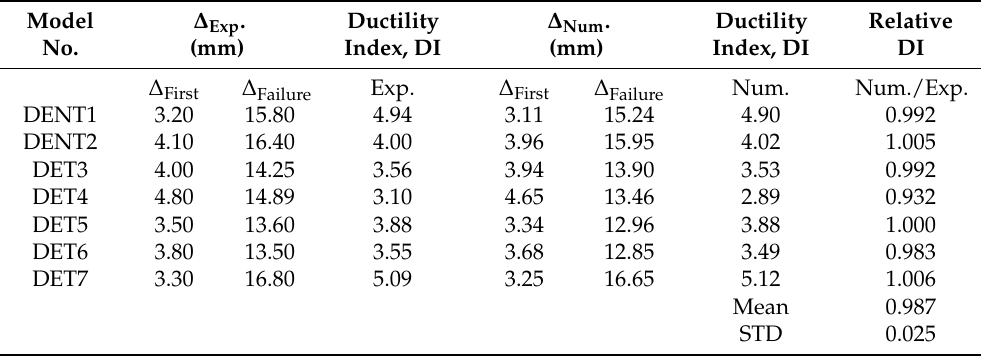
Table 5. Comparison of the experimental and numerical results of the ductility indexes based on the mid-span deflections of the RC girder models with dapped